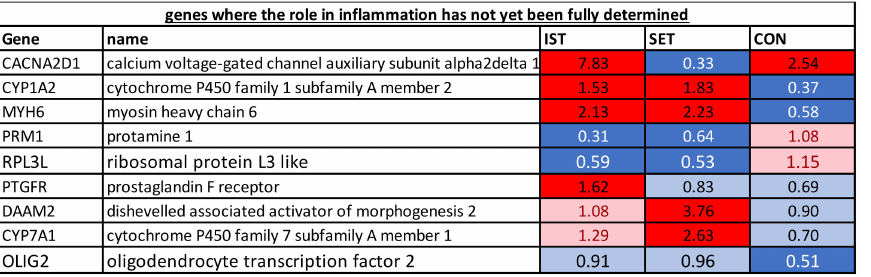
Figure 5. The genes of which the exact immune-modulatory role in the context of exercise has not yet been described and of which the expression was changed significantly in at least one of the groups. FC of the genes represent the change from baseline to 3 months intervention. Dark blue: genes that were downregulated after the intervention (FC of ≤ 0.67). Light blue: genes showing a tendency towards downregulation after the intervention (1 > FC < 0.67). White: genes of which expression was not altered after the intervention (FC = 1); Pink: genes showing a tendency towards upregulation after the intervention (1 < FC < 1.5). Red: genes that were upregulated after the intervention (FC ≥